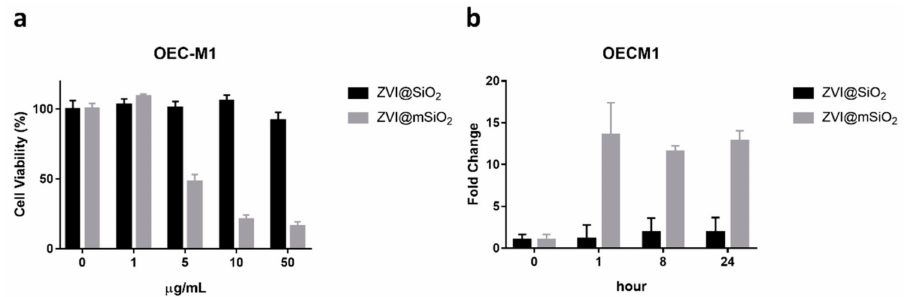
Figure 2. The cytotoxicity and reactive oxygen species (ROS) assay of ZVI@SiO 2 - and ZVI@mSiO 2 NP-treated OEC-M1 oral cancer cells. ( a ) NP-exposed cells were analyzed using 3-(4,5-dimethylthiazol-2-yl)-2,5-diphenyltetrazolium bromide (MTT) assay after 24-h treatment. The cells were significantly more sensitive to ZVI@mSiO 2 exposure than to ZVI@SiO 2 exposure. ( P = 0.0342, Student’s t -test) ( b ) 10 µ g / mL ZVI@SiO 2 treatment only slightly increased the ROS production in the cells; however, the cells exposed to ZVI@mSiO 2 at the same dosage showed a drastic increase in ROS immediately after 1-h treatment. ( P = 0.0304, Student’s t